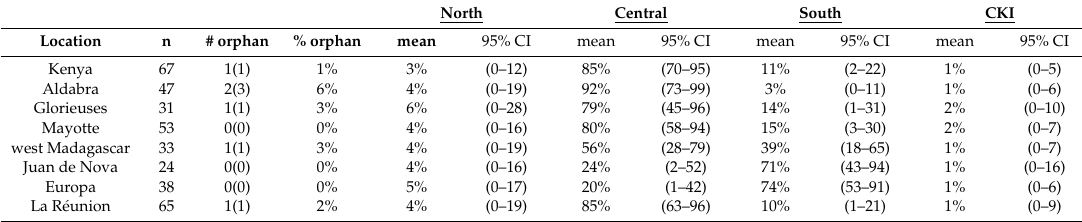
Table 2. Results from the “many-to-many” mixed stock analysis (MSA) using the package “mixstock” in R for eight green turtle (Chelonia mydas) feeding grounds in the Southwest Indian Ocean. Shown are the locations, sample size (n), number of orphan haplotypes (#orphan (total individuals)), percentage of orphan haplotypes (orphan), mean contribution from each of the three SWIO nesting stocks as well as Cocos (Keeling) Island (CKI) and 95% confidence interval. North Central South CKI